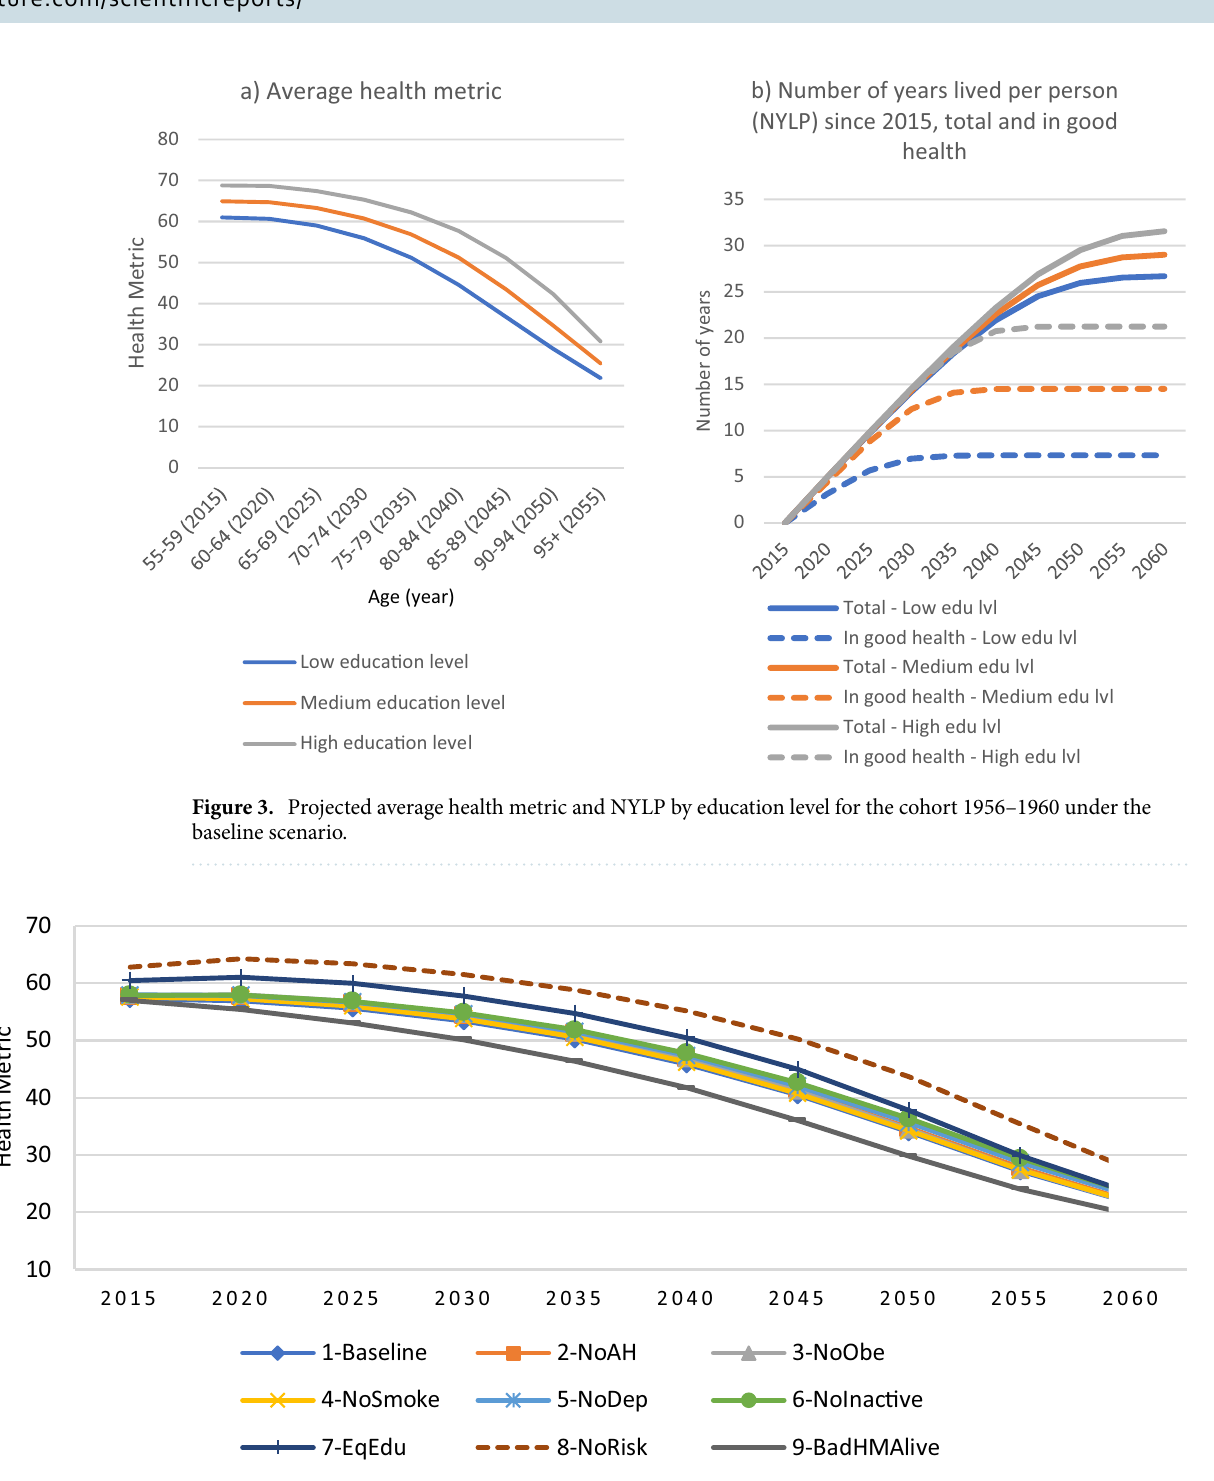
Figure 4. Projected average health metric for cohorts 1916–1960 under different